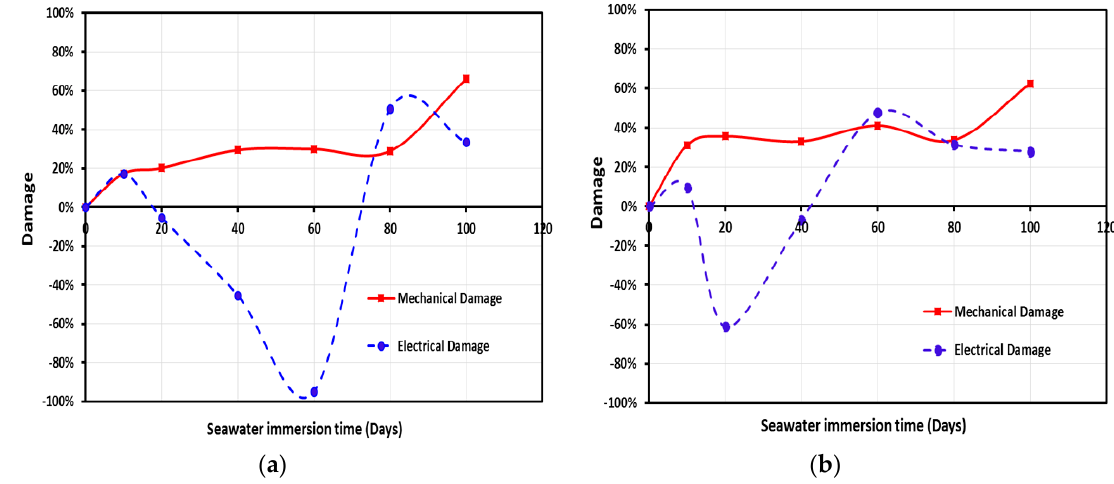
Figure 13. The mechanical and electrical damage for CNFs/GFRP composite vs. immersion time at temperatures ( a ) 22 °C and ( b ) 45 °C.